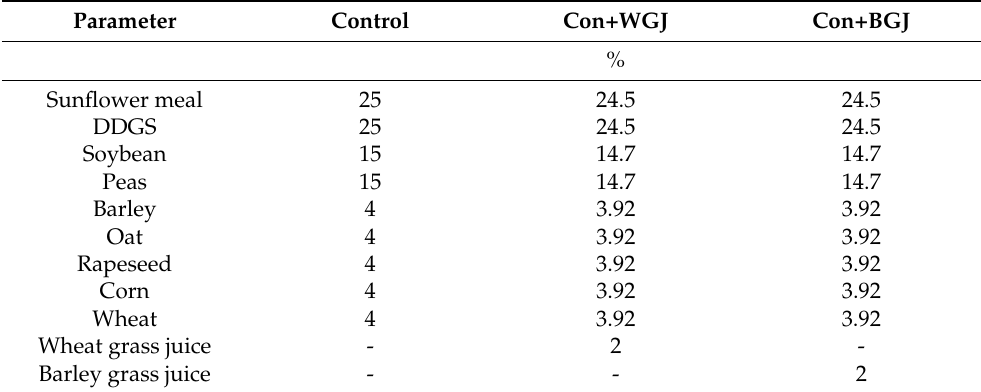
Table 1. Diets composition in % as fed